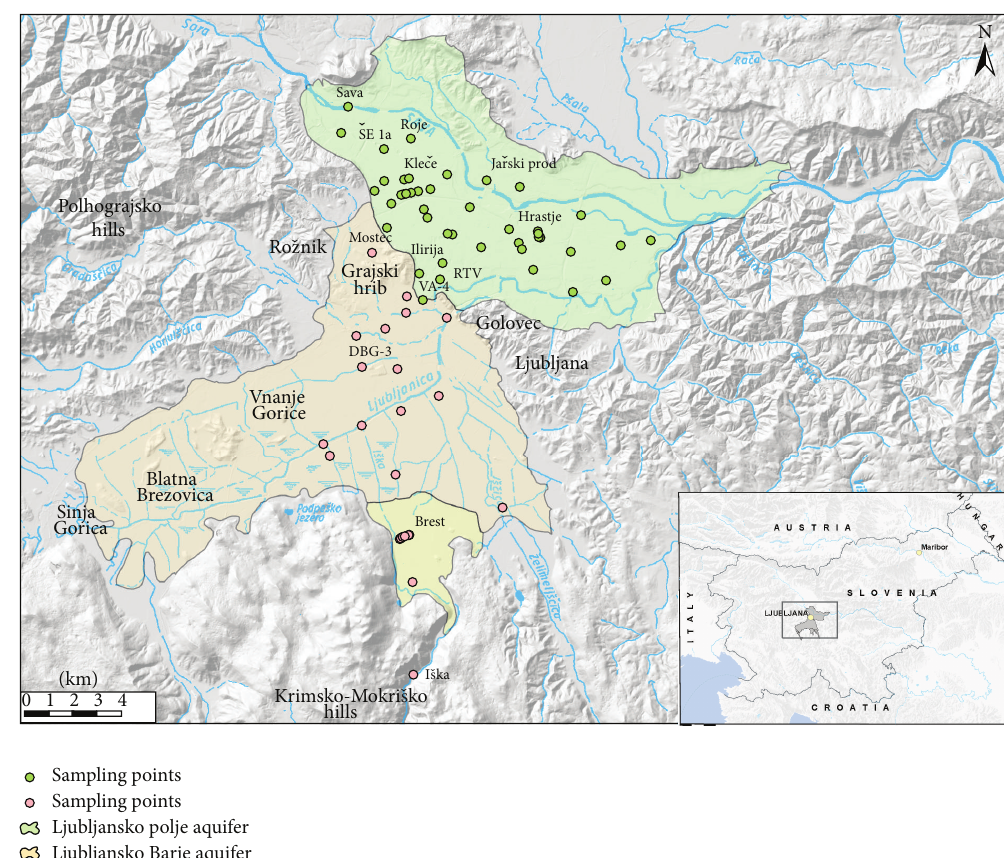
Figure 1: Location map of study area and groundwater sampling